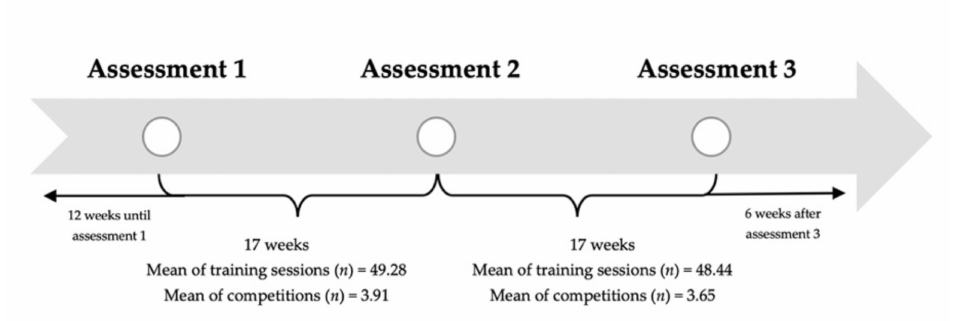
Figure 1. Timeline of assessments during 52 weeks of